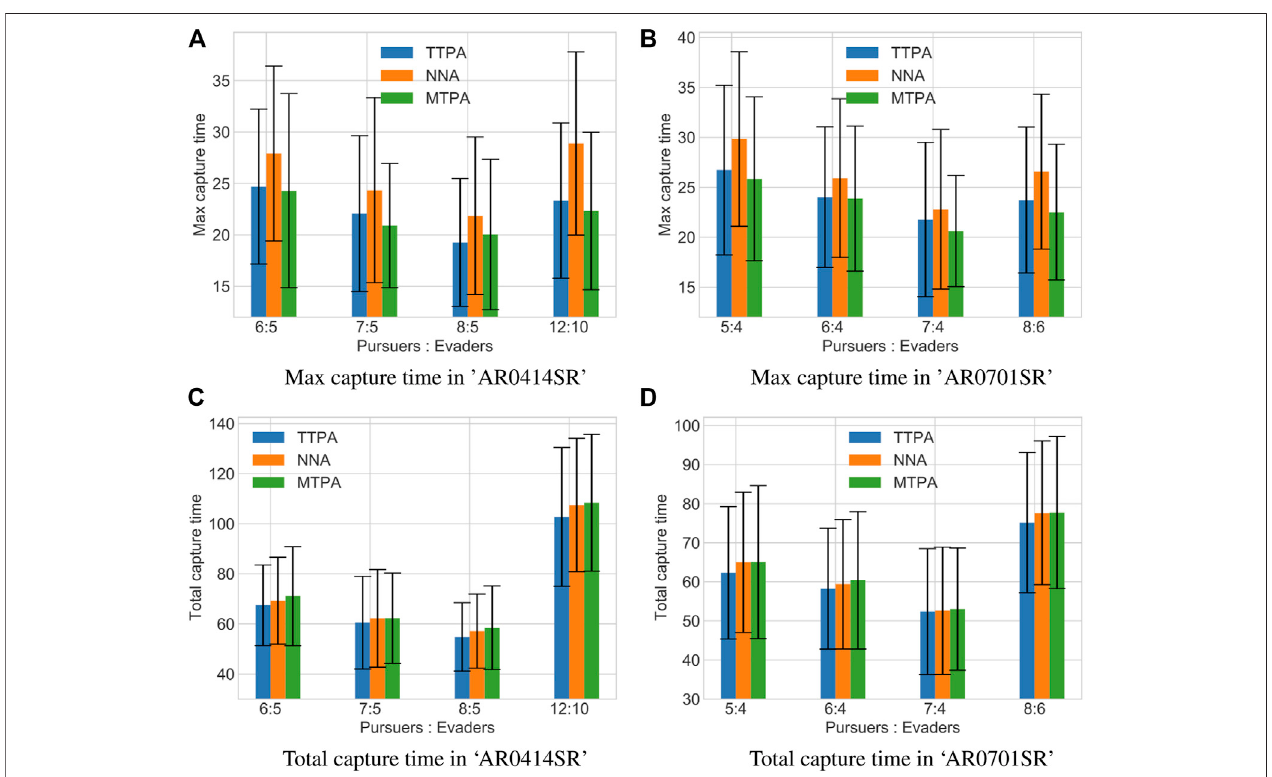
FIGURE 7 | Comparison of the average values of maximum capture times (A, B) and total capture times (C, D) along with the standard deviation in different environments and with different pursuer-to-evader ratios using the TTPA, NNA and MTPA algorithms. Each bar represents data from 100 simulations with randomized initial conditions.